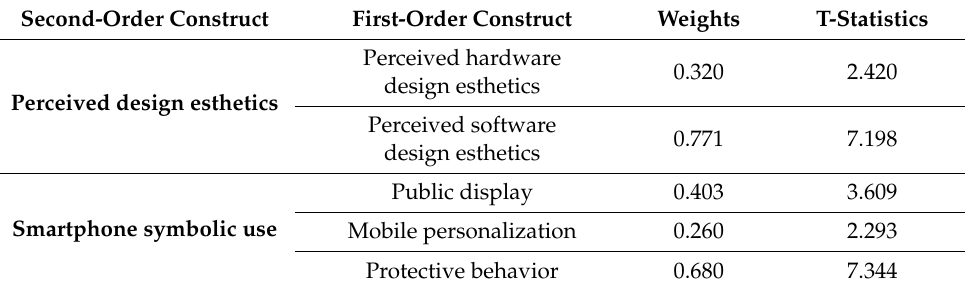
Table 7. Weights of formative